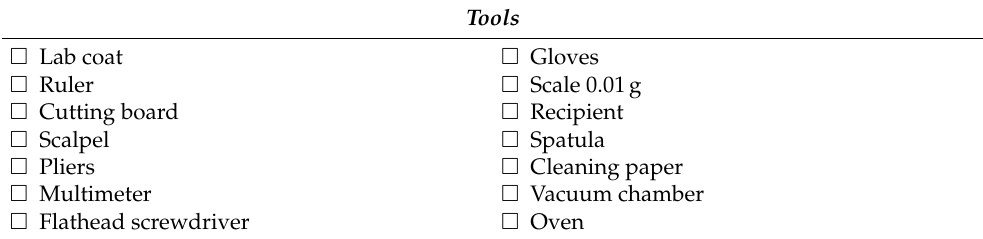
Table 1. List of tools and bill of materials. Components are sorted by the part in which they are first used. Components used in multiple parts are only listed once. For detailed info, see the instruction document on the Zenodo repository